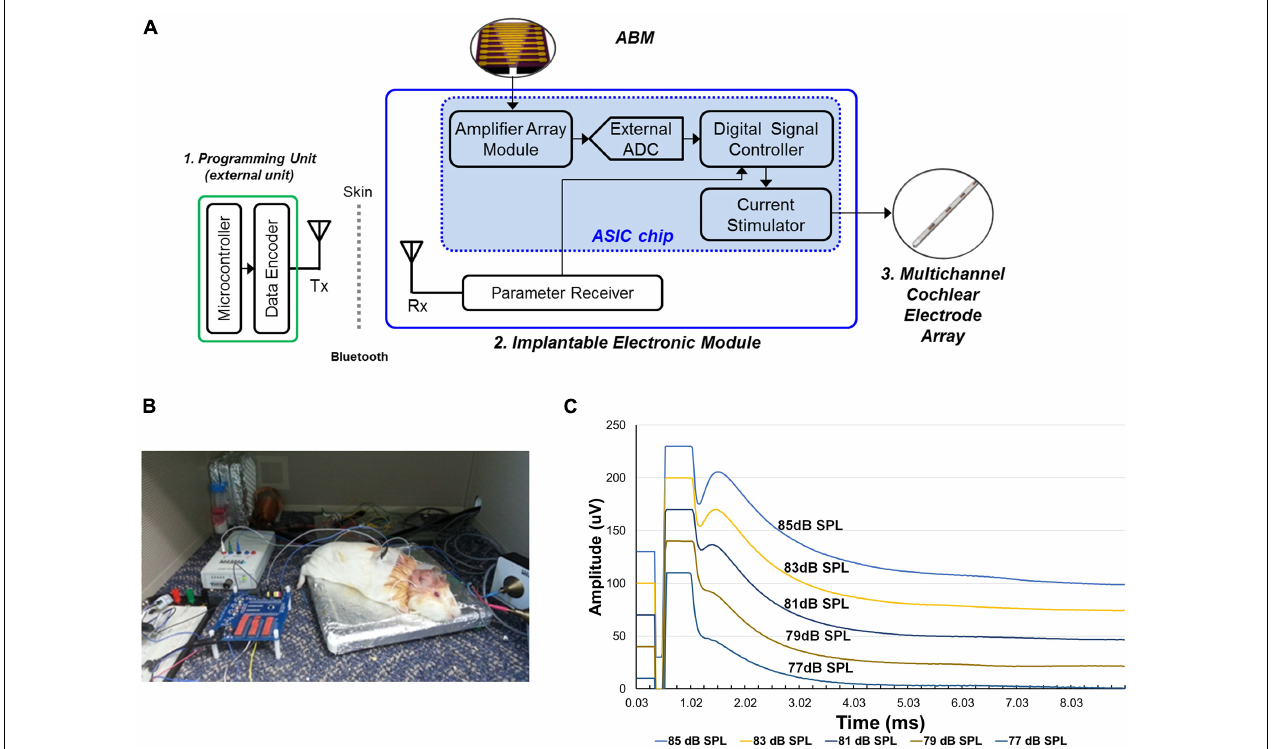
FIGURE 3 | The development and functional evaluation of the Electronic module. (A) Schematic model of electronic module. (B) Experimental setup of eABR recordings from the guinea pig with implanted electrode connected to the electronic module. (C) The result of eABR wave by stimulus strength. The second positive (P2) wave gradually increased in amplitude as the sound stimulus